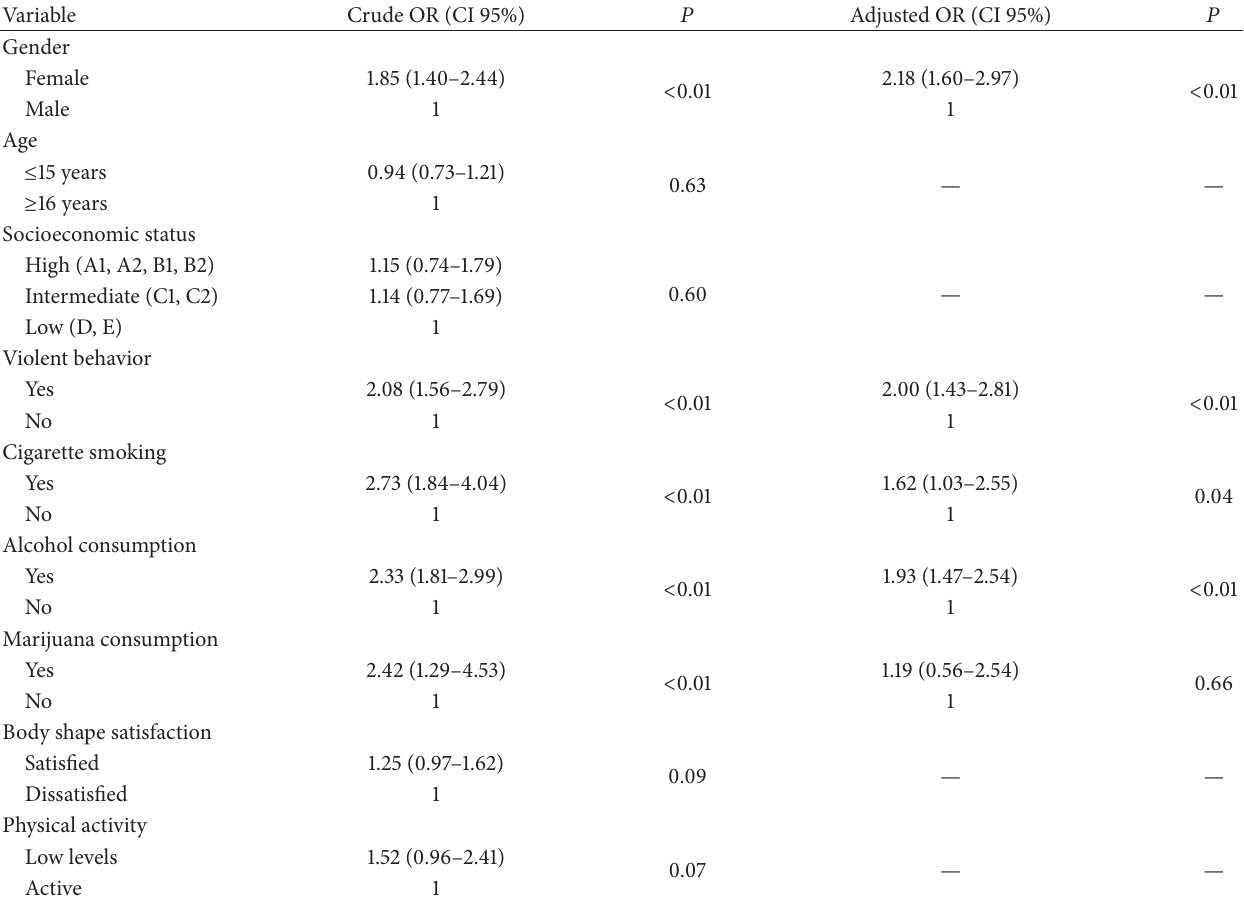
Table 3: Crude and adjusted odds ratio for behavior “suicide ideation” among adolescents in Northeastern Brazil, 𝑛 = 2207.